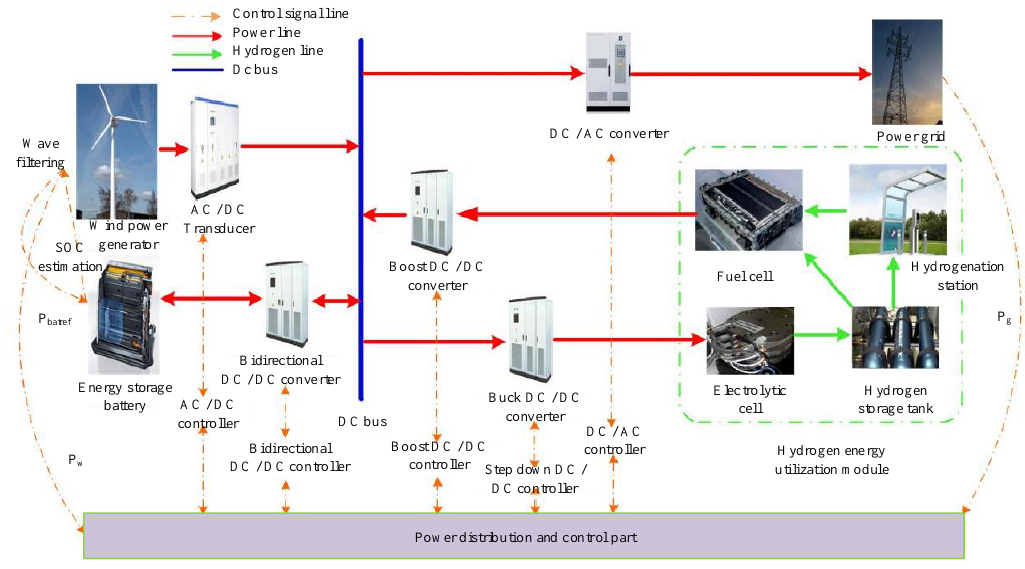
Figure 1. Topology diagram of distributed wind-hydrogen hybrid energy system.